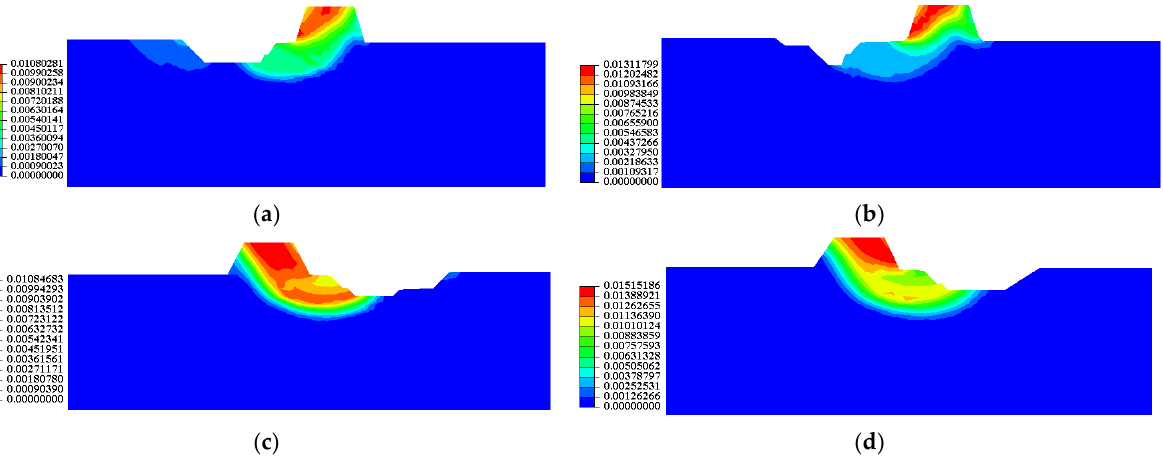
Figure 11. Diagram of the simulation results of displacement of dangerous sections under condition